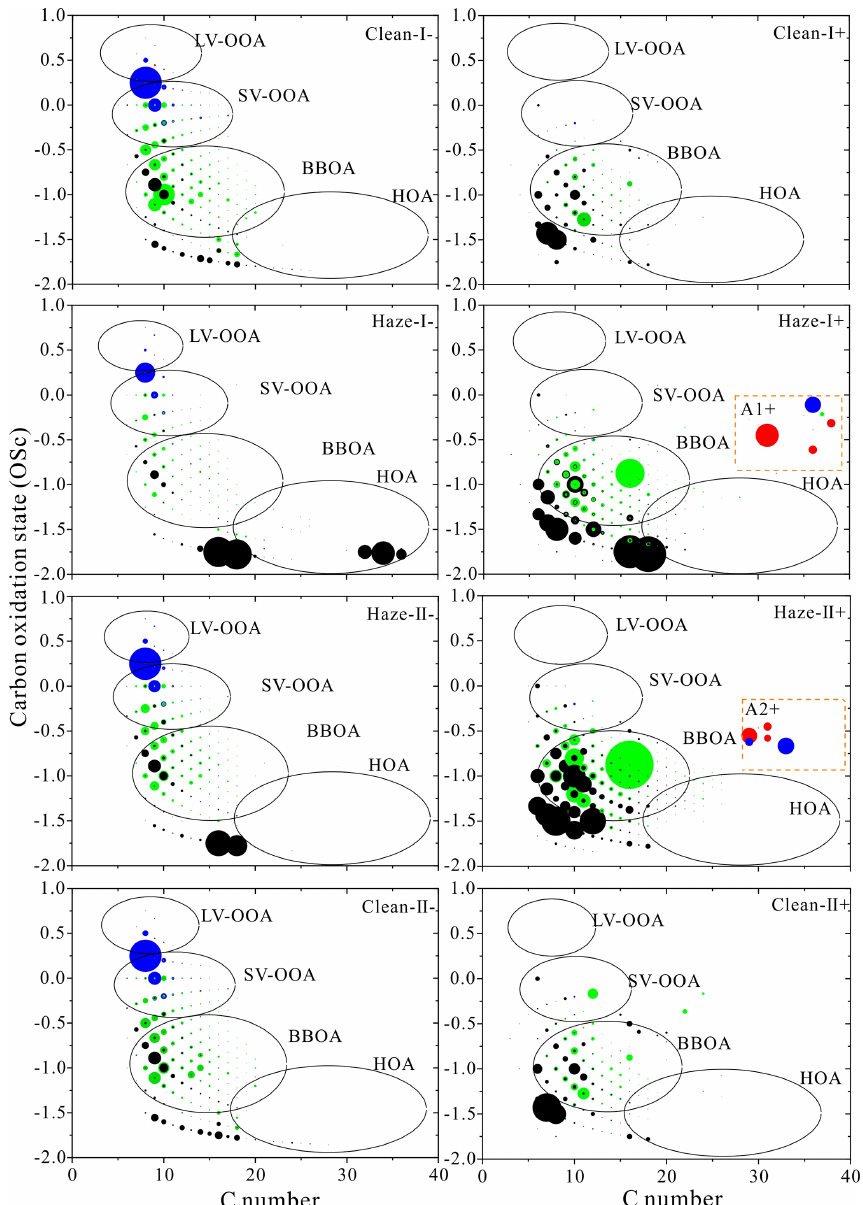
Figure 3. Carbon oxidation state (OS C ) plots for CHO − and CHO + . Formulas with black, green, blue, and red are assigned to aliphatic (AI = 0), olefinic (0 < AI < 0 . 5), aromatic (0 . 5 ≤ AI < 0 . 67), and condensed aromatic (AI ≥ 0 . 67) species (Koch and Dittmar, 2006), re-